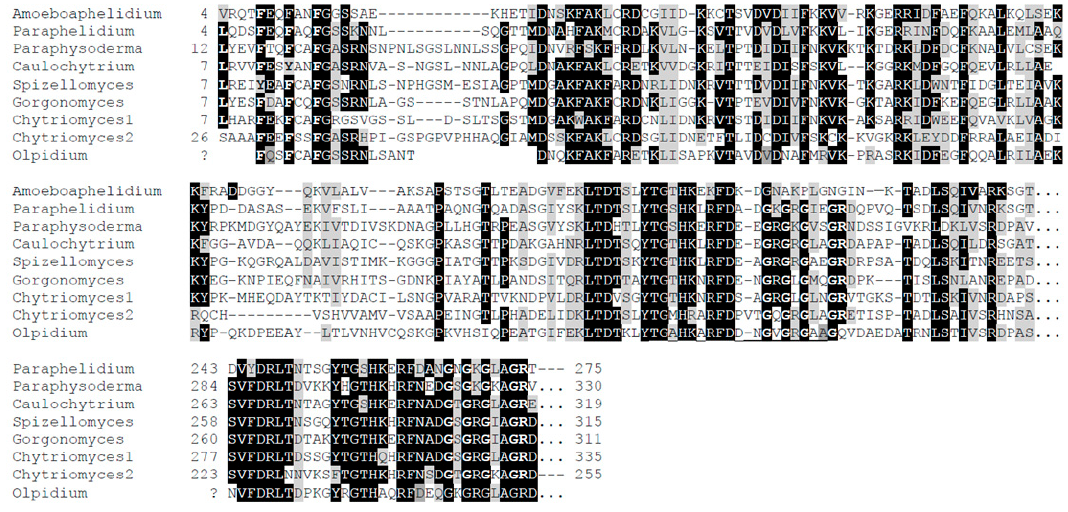
Figure 2. Comparison of the sequence of Amoeboaphelidium protococcorum TPPP with those of some long (animal)-type TPPPs. Multiple sequence alignment (manually re fi ned) was conducted by Clus- tal Omega [15]. Amoeboaphelidium, A. protococcorum strain X5 KAI3631655 (Fungi); Obelidium, Ob- elidium mucronatum KAI9342551 (Fungi); Gorgonomyces, Gorgonomyces haynaldii KAI8912823 (Fungi); Monosiga, Monosiga brevicollis XP_001743131 (Choano fl agellata); Sorex, Sorex araneus XP_004609762 (Animals). Amino acids that are identical and biochemically similar in all but one protein are labeled by a black and grey background, respectively. An NCBI Blast search was not possible for P. tribonematis as there were no P. tribone- matis data on this site. However, its metatranscriptomic nucleotide contig assembly and the predicted proteome were deposited in fi gshare [13]. My analysis of the proteome re-